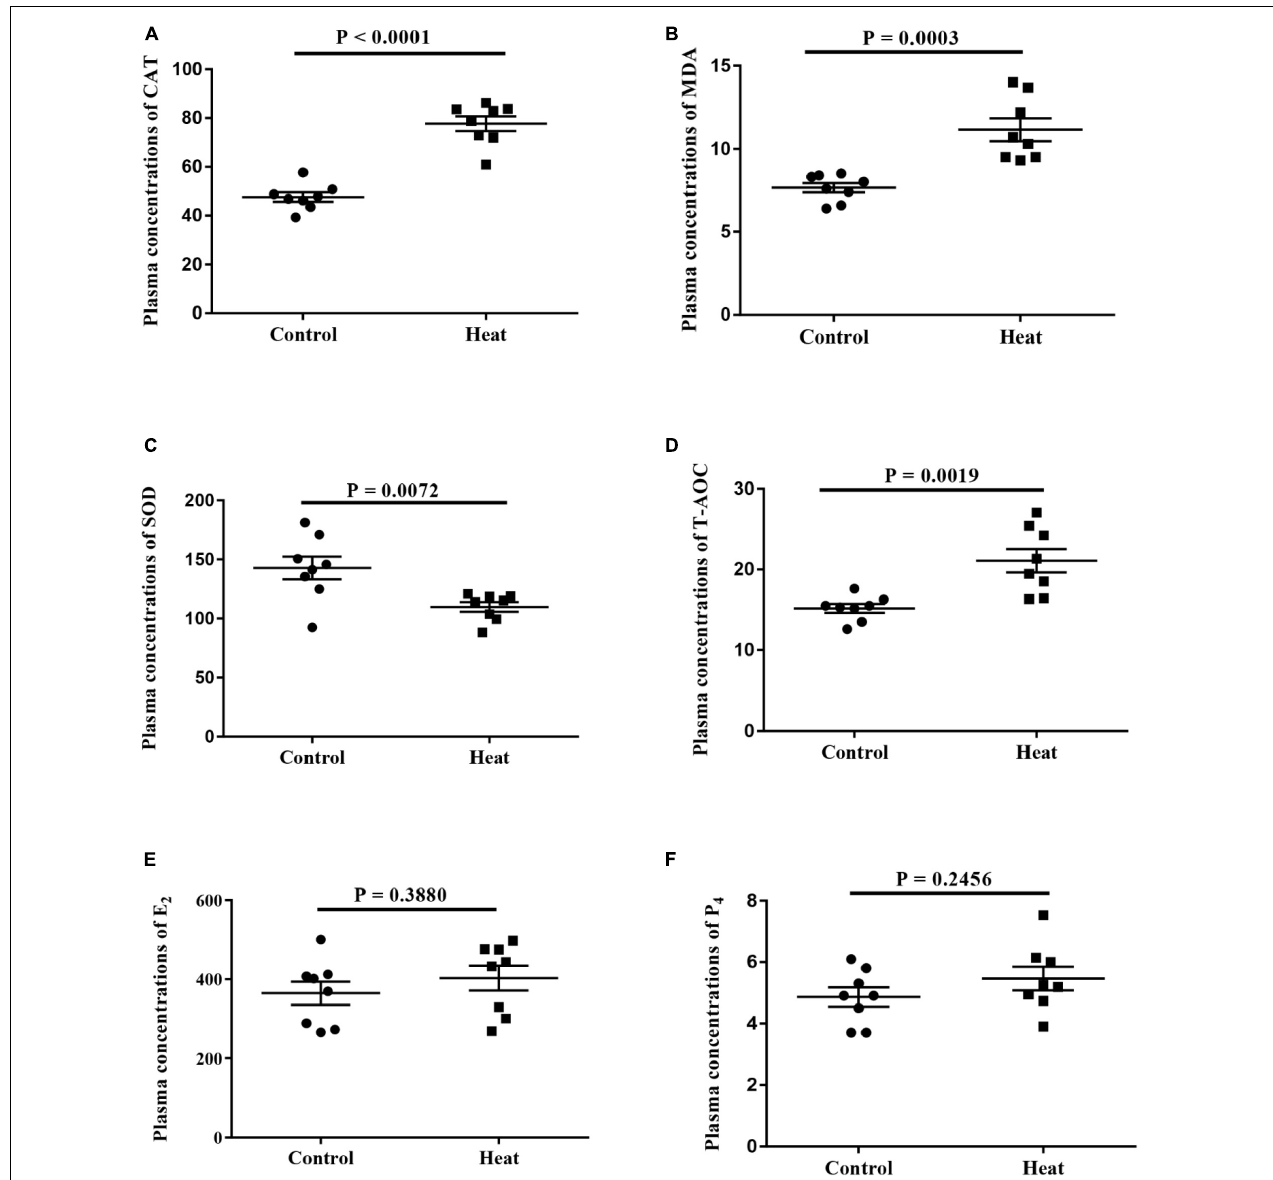
FIGURE 1 | (A–D) The levels of oxidative stress-related biomarkers including superoxide dismutase (SOD), total antioxidant capacity (T-AOC), catalase (CAT) and malondialdehyde (MDA) in the serum are detected, respectively. (E,F) The levels of estrogen (E2) and progesterone (P4) in the serum are detected. A P < 0.05 indicates statistically significant difference ( t -test). Error bar indicates the standard error of the